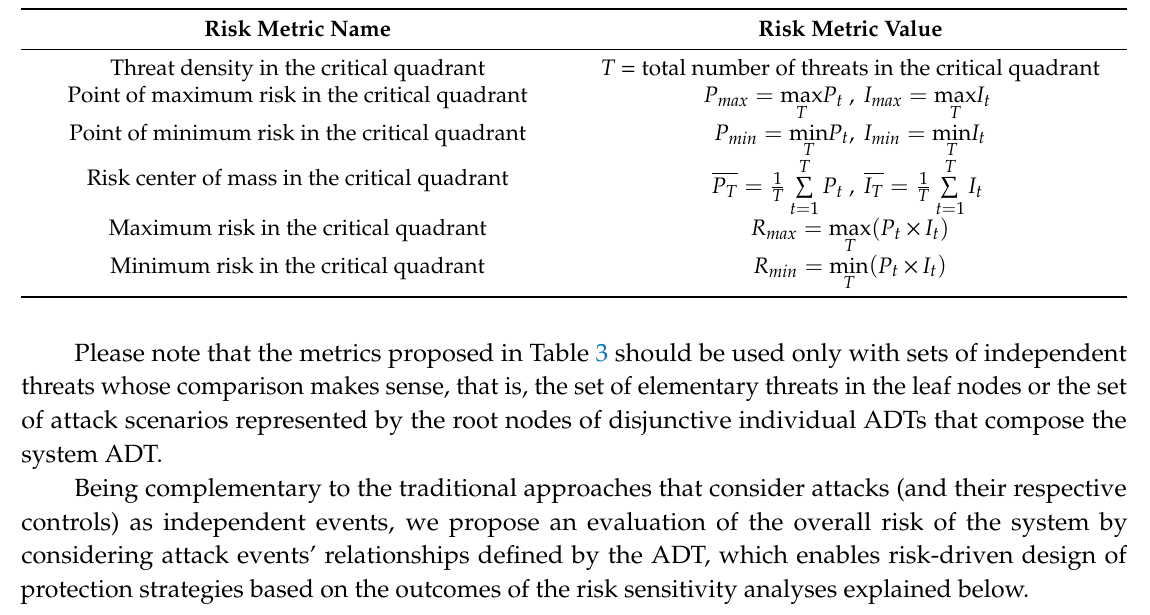
Table 3. Risk level severity metrics